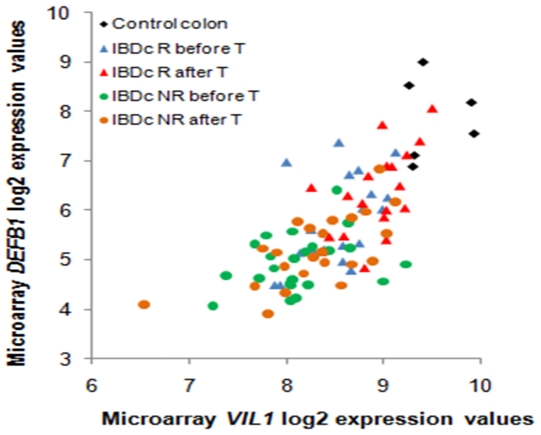
Scatterplot representing correlation between colonic microarray log2 expression values of DEFB1 and VIL1.R: responders; T: treatment.